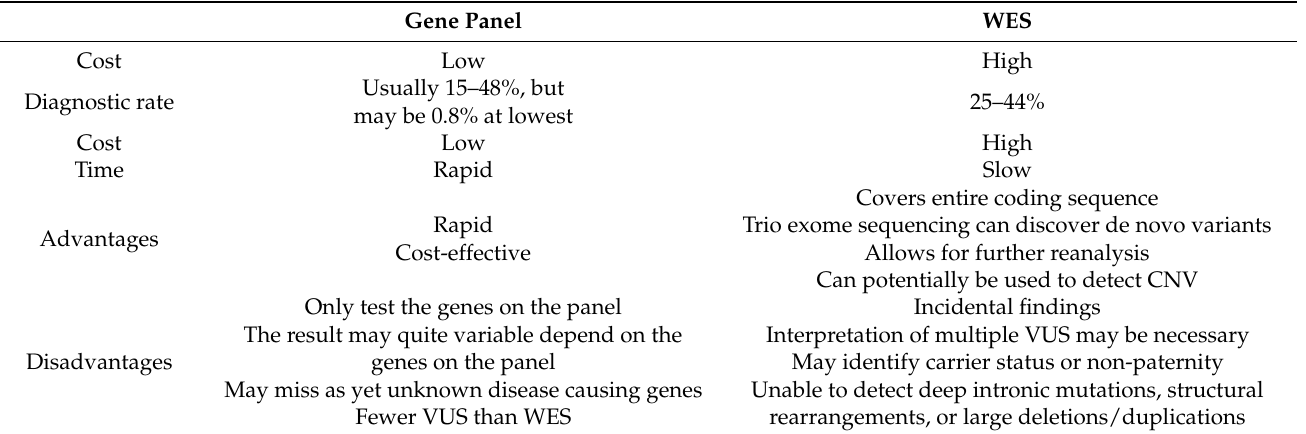
Table 1. Characteristics of gene panels versus